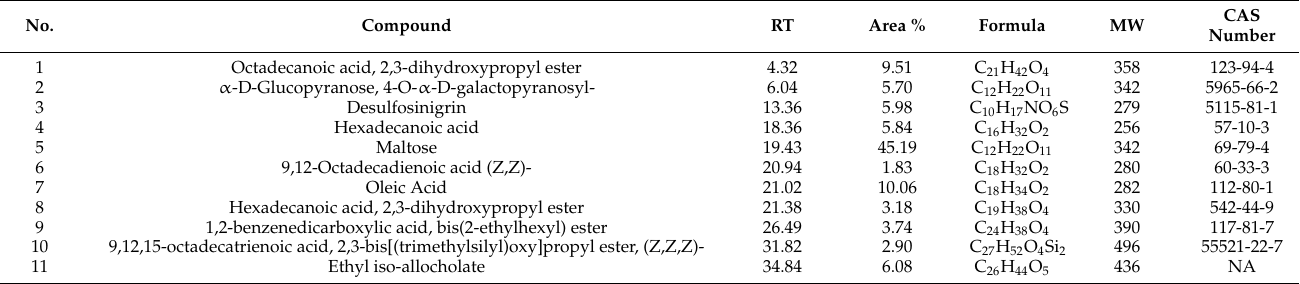
Table 2. Chemical composition of methanolic fruit mesocarp extract of neem screened by